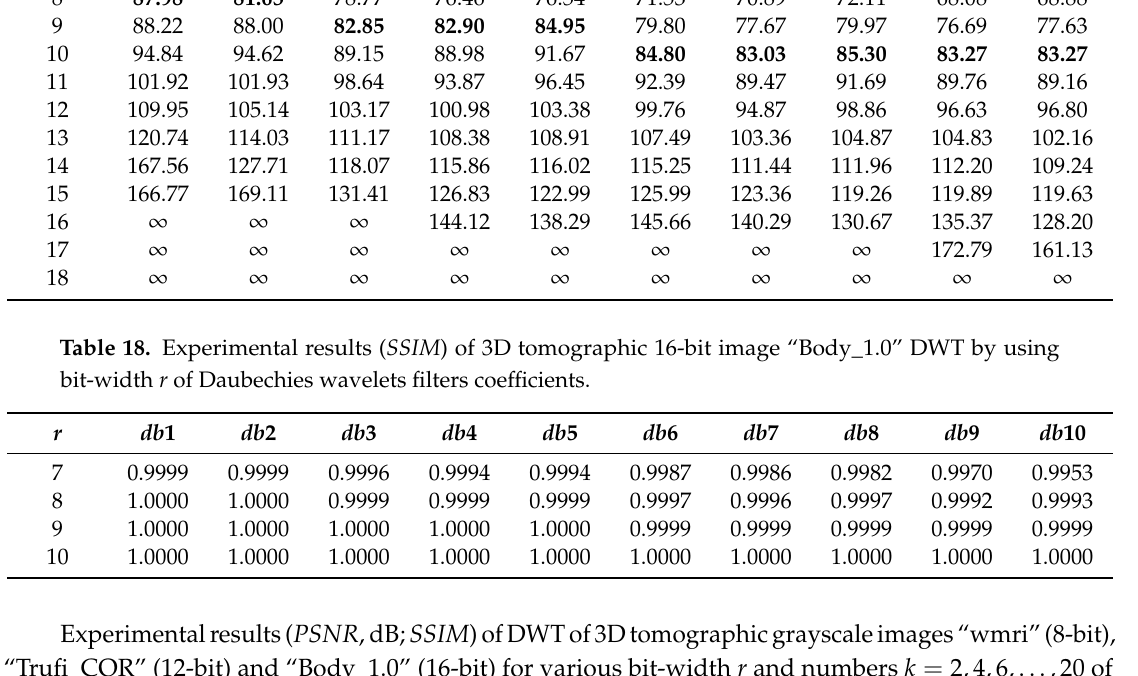
Experimental results ( PSNR , dB; SSIM ) of DWT of 3D tomographic grayscale images “wmri” (8-bit), “Trufi_COR” (12-bit) and “Body_1.0” (16-bit) for various bit-width r and numbers k = 2, 4, 6, . . . , 20 of